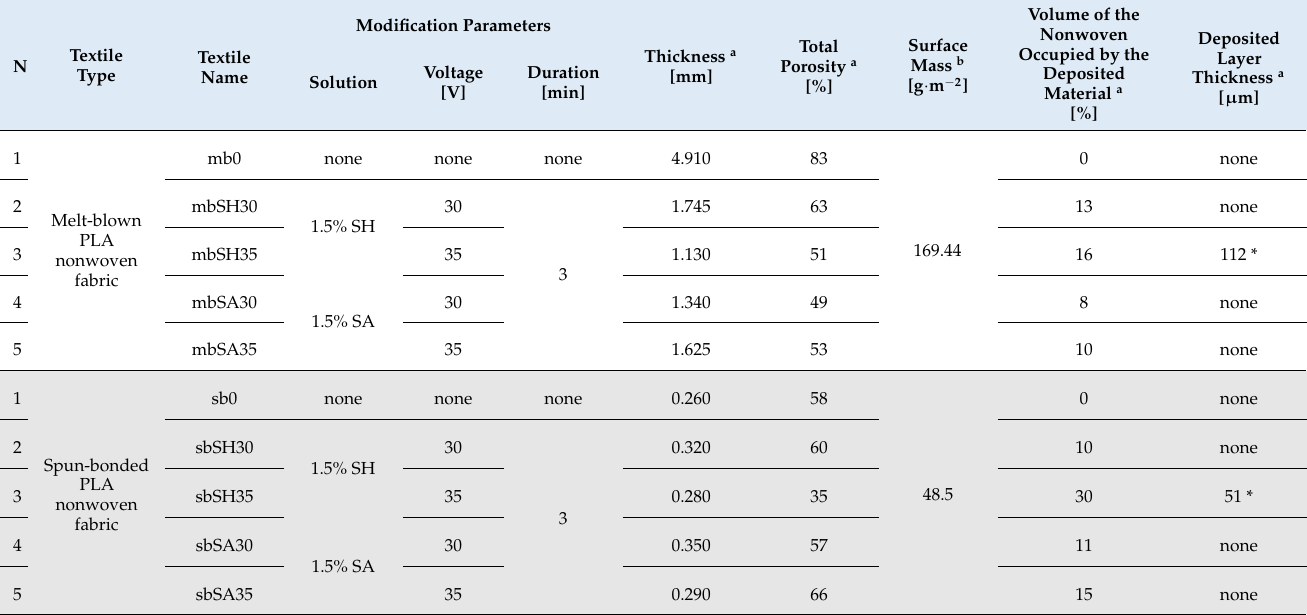
Table 2. Characteristics of the tested nonwovens.